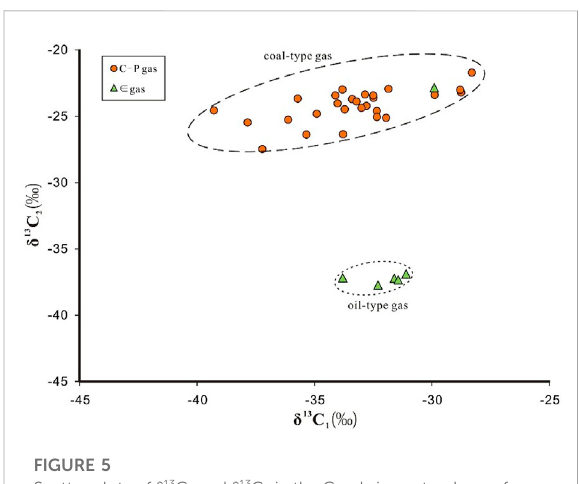
FIGURE 6 Trace element ratio scatterplot shows solid bitumen in